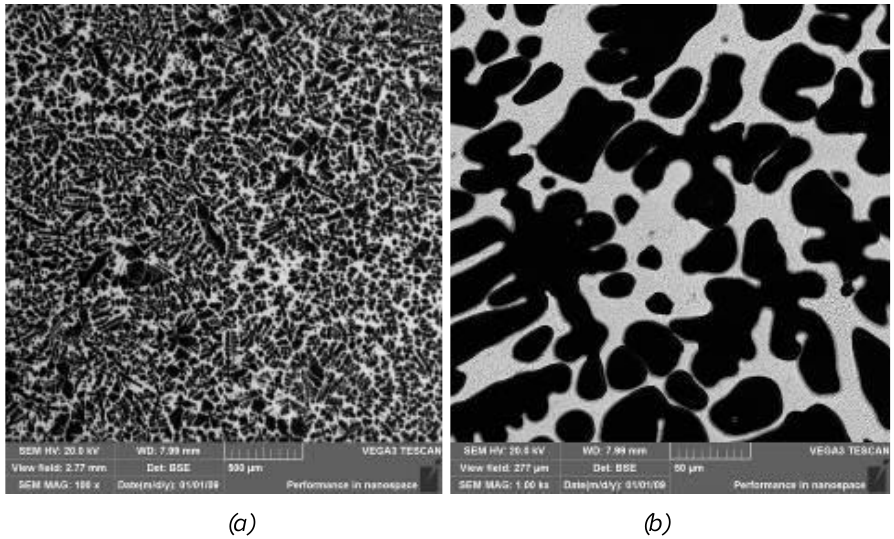
Fig. 5. SEM image of the Bi 30.7 Cu 69.3 alloy: (a) magnification 100X; (b) magnification